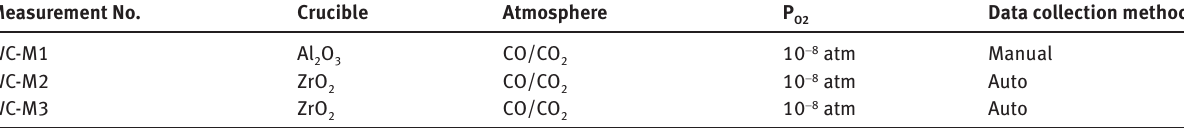
Table 3: The crucible materials and atmospheres used in the viscosity measurements